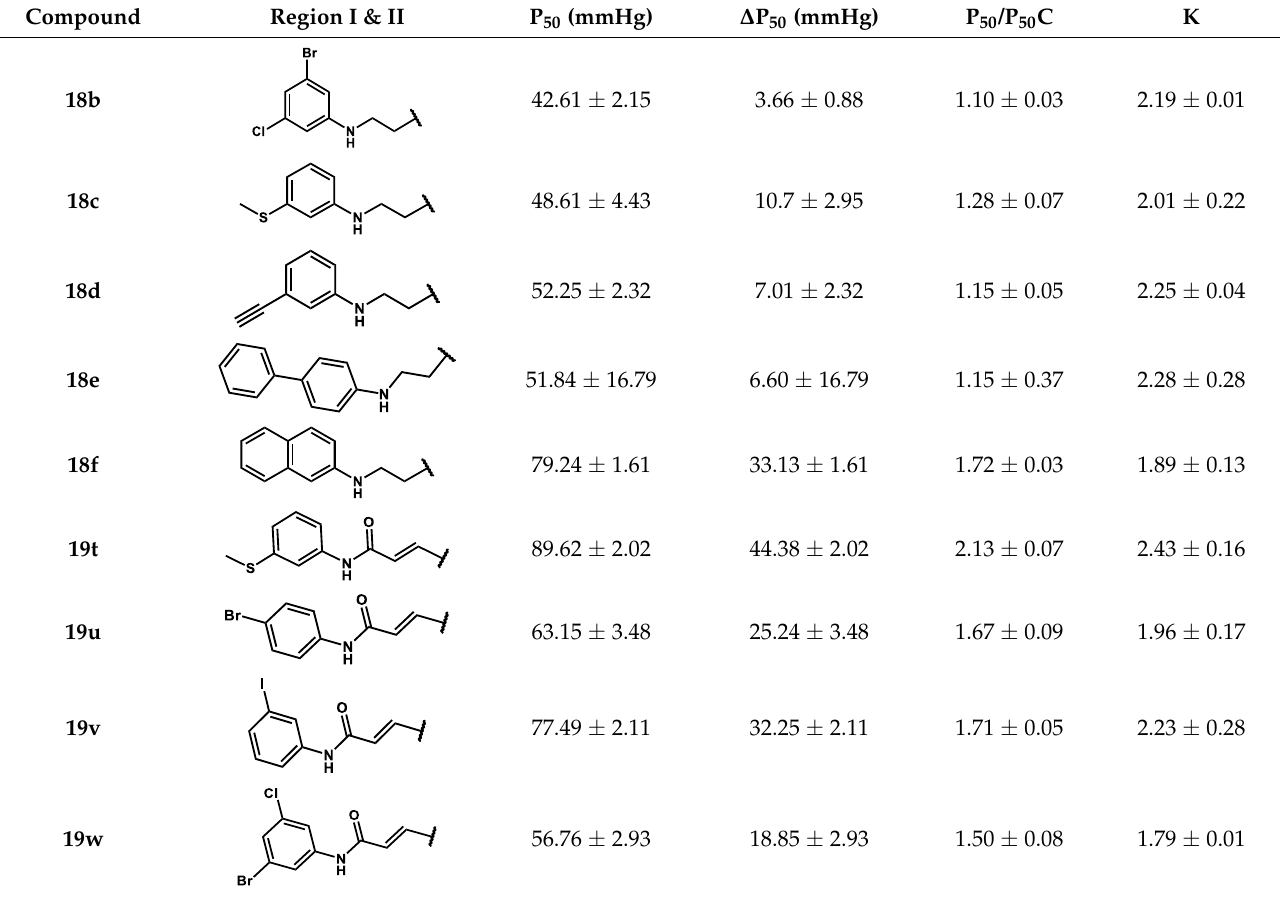
Table 4. Results of in vitro red blood cell studies.